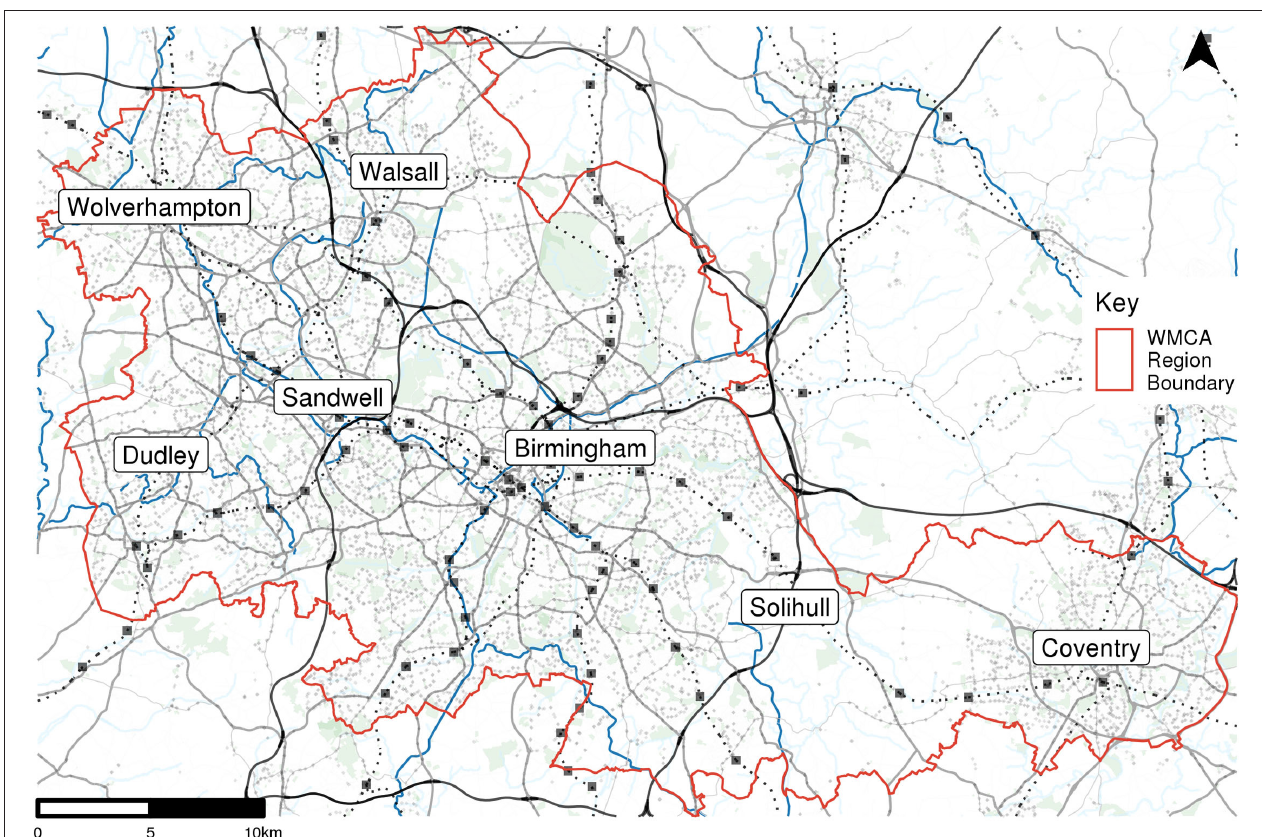
FIGURE 1 | The study region, West Midlands Combined Authority (WMCA), and its seven constituent local authorities.